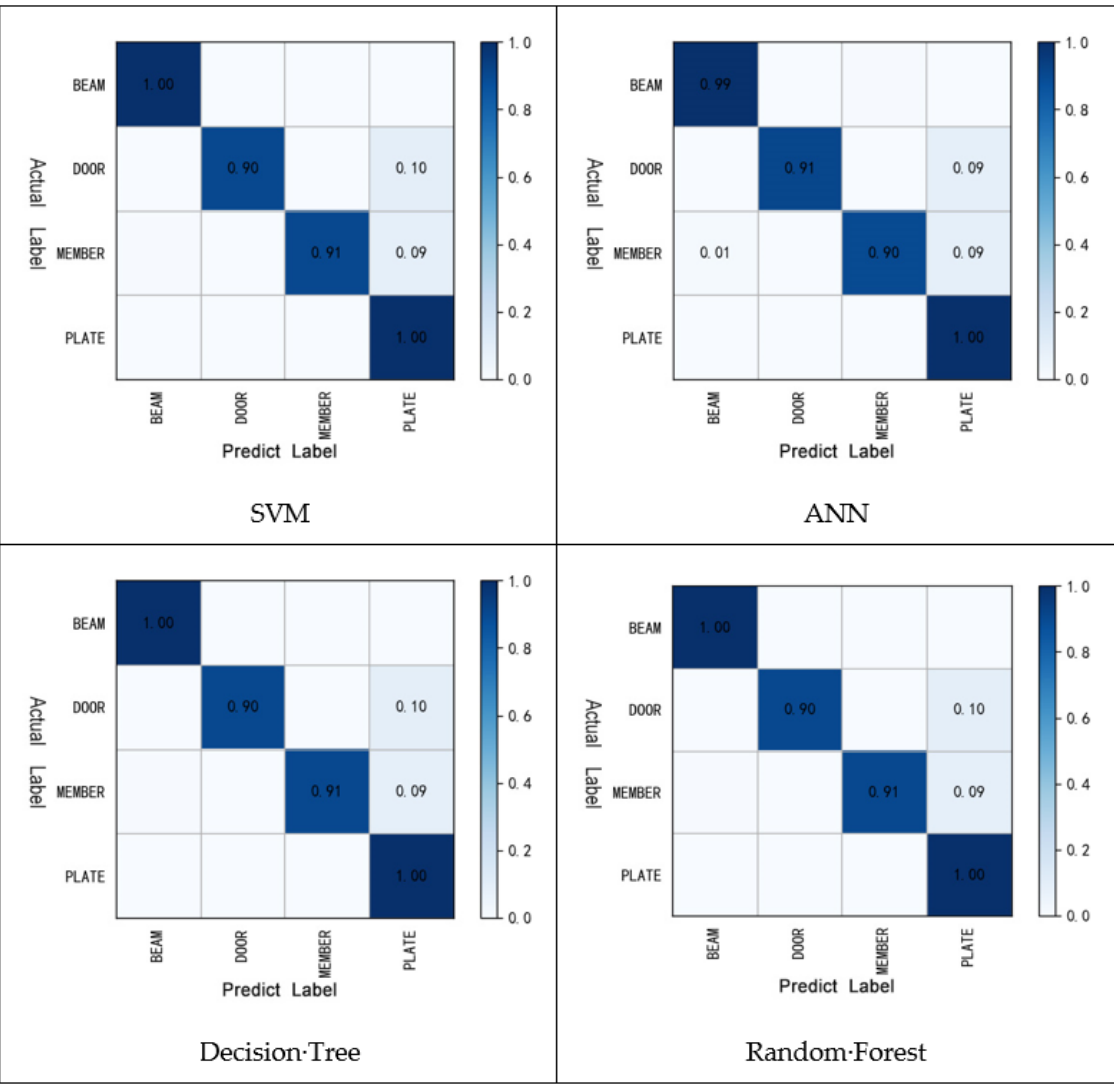
Figure 13. Confusion matrix about Data 4.